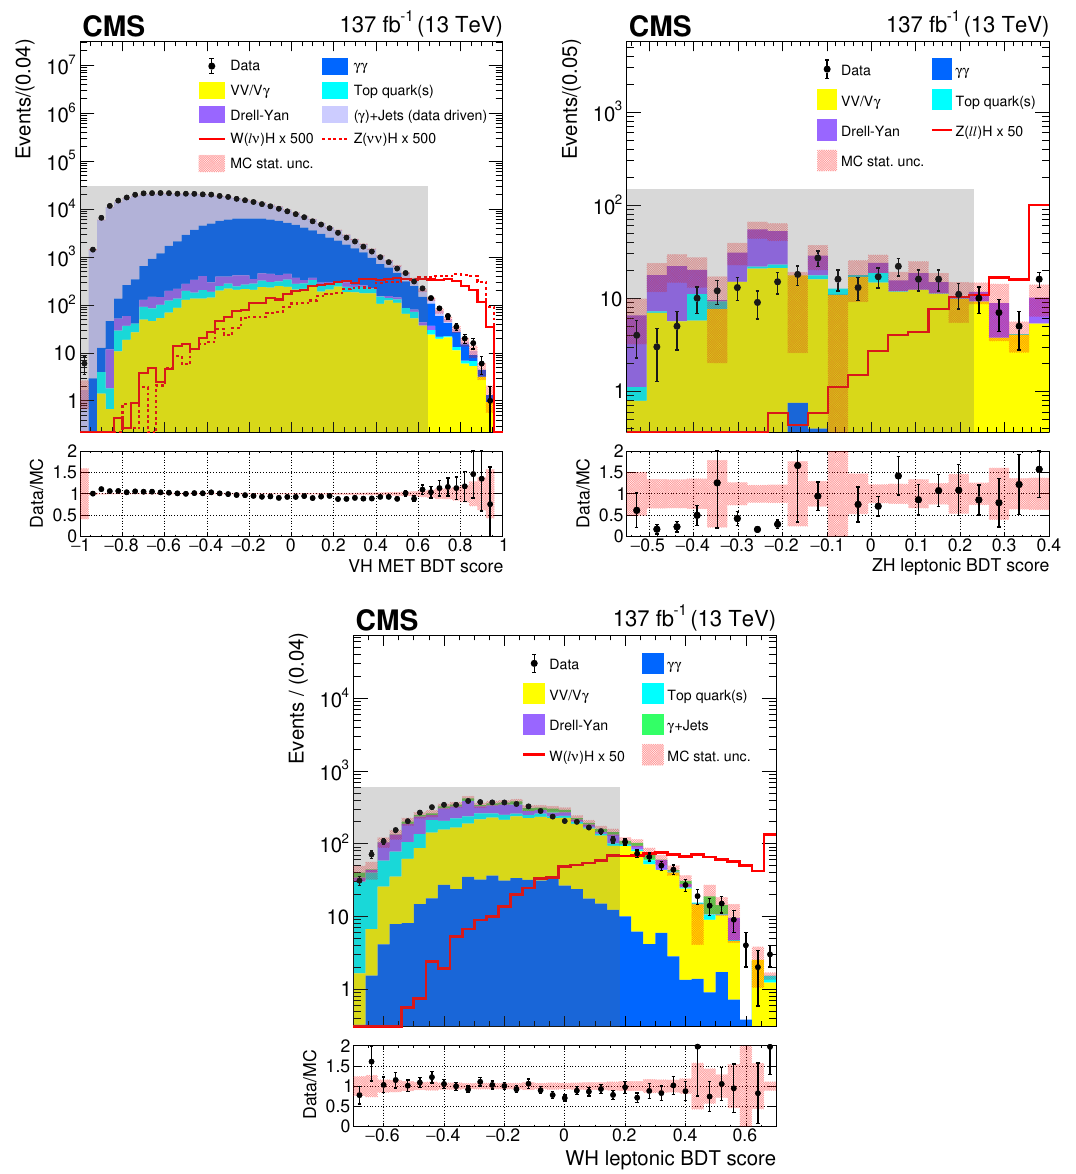
Figure 9 . Output scores for the three VH leptonic BDTs. The VH MET BDT is shown in the upper left, with the ZH leptonic BDT in the upper right, and the WH leptonic BDT below. In each case, the signal and background simulation are shown as histograms with the data as black points. Events are taken from the m sidebands, satisfying either 100 < m < 120 GeV or gg gg 130 < m < 180 GeV. The statistical uncertainty in the data points is denoted as vertical bars gg and that on the background simulation by the pink band. The simulated signal and background distributions are normalised to the luminosity of the data. To increase its visibility, the signal is scaled by a factor of 500 for the VH MET BDT, with a factor of 50 applied for both ZH leptonic and WH leptonic BDTs. The regions shaded grey are not considered in the analysis. The full data set collected in 2016–2018 and the corresponding simulation are